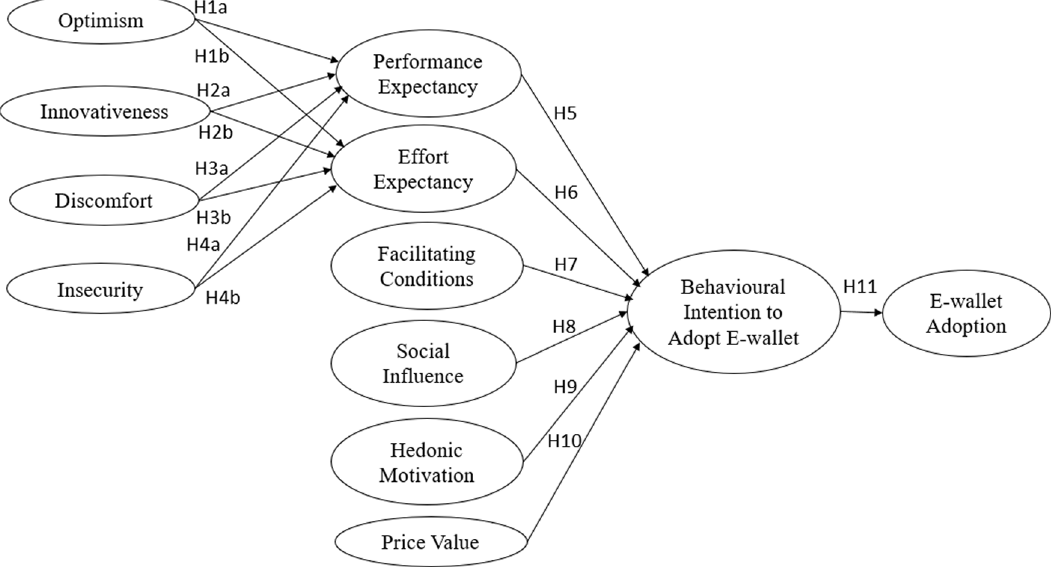
Figure 1. Research